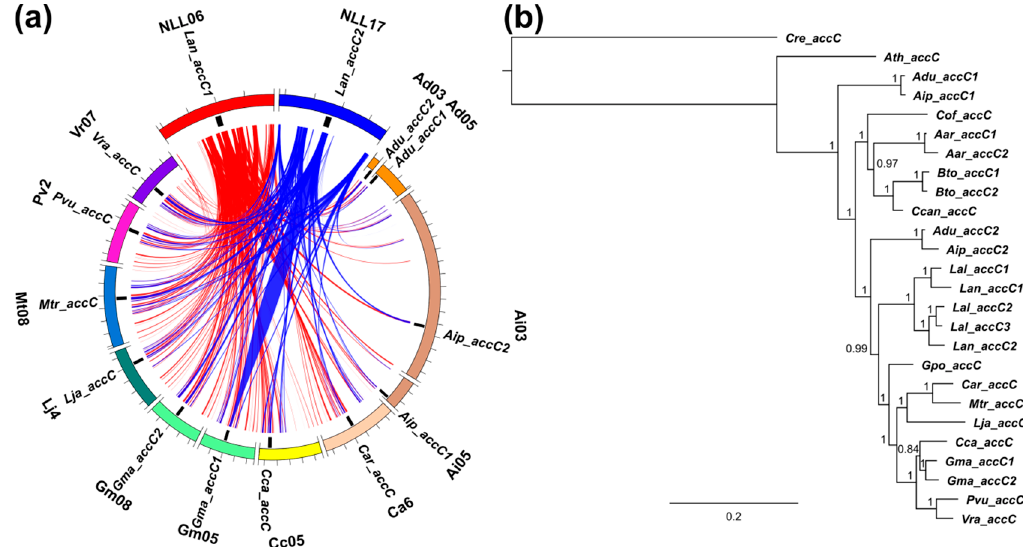
Figure 8. Comparative mapping and phylogenetic inference of legume biotin carboxylase ( accC ) subunit